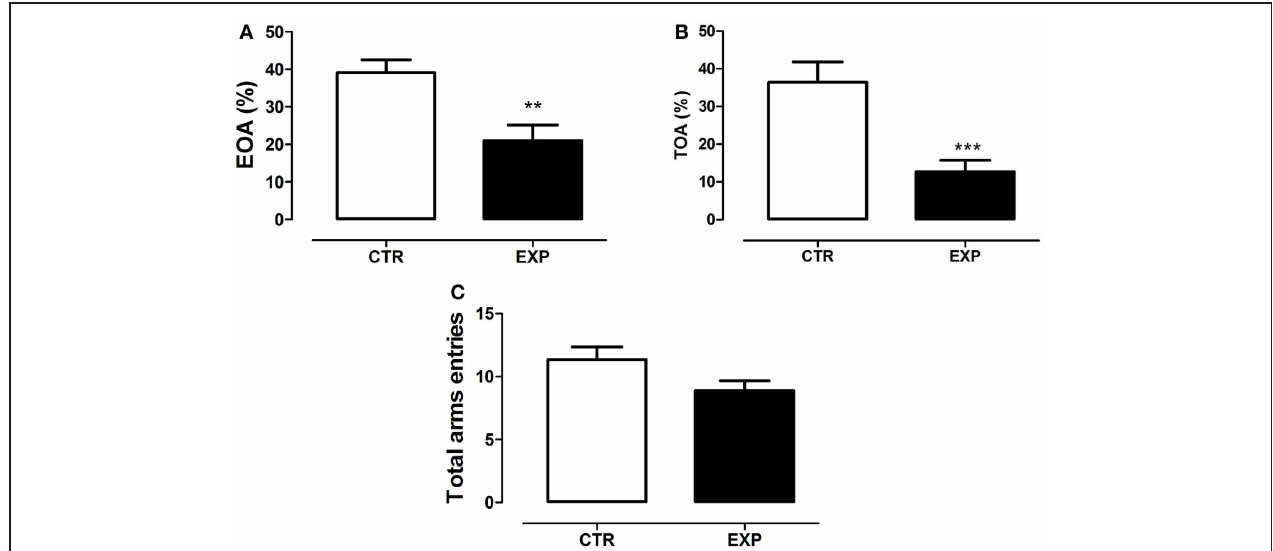
FIGURE 5 | Percentage of entries onto the open arms (A), percentage of time spent on the open arms (B) and total entries in both arms (C) are shown as mean ± standard error. Control group (CTR) n = 14 and Experimental group (EXP), n = 16.